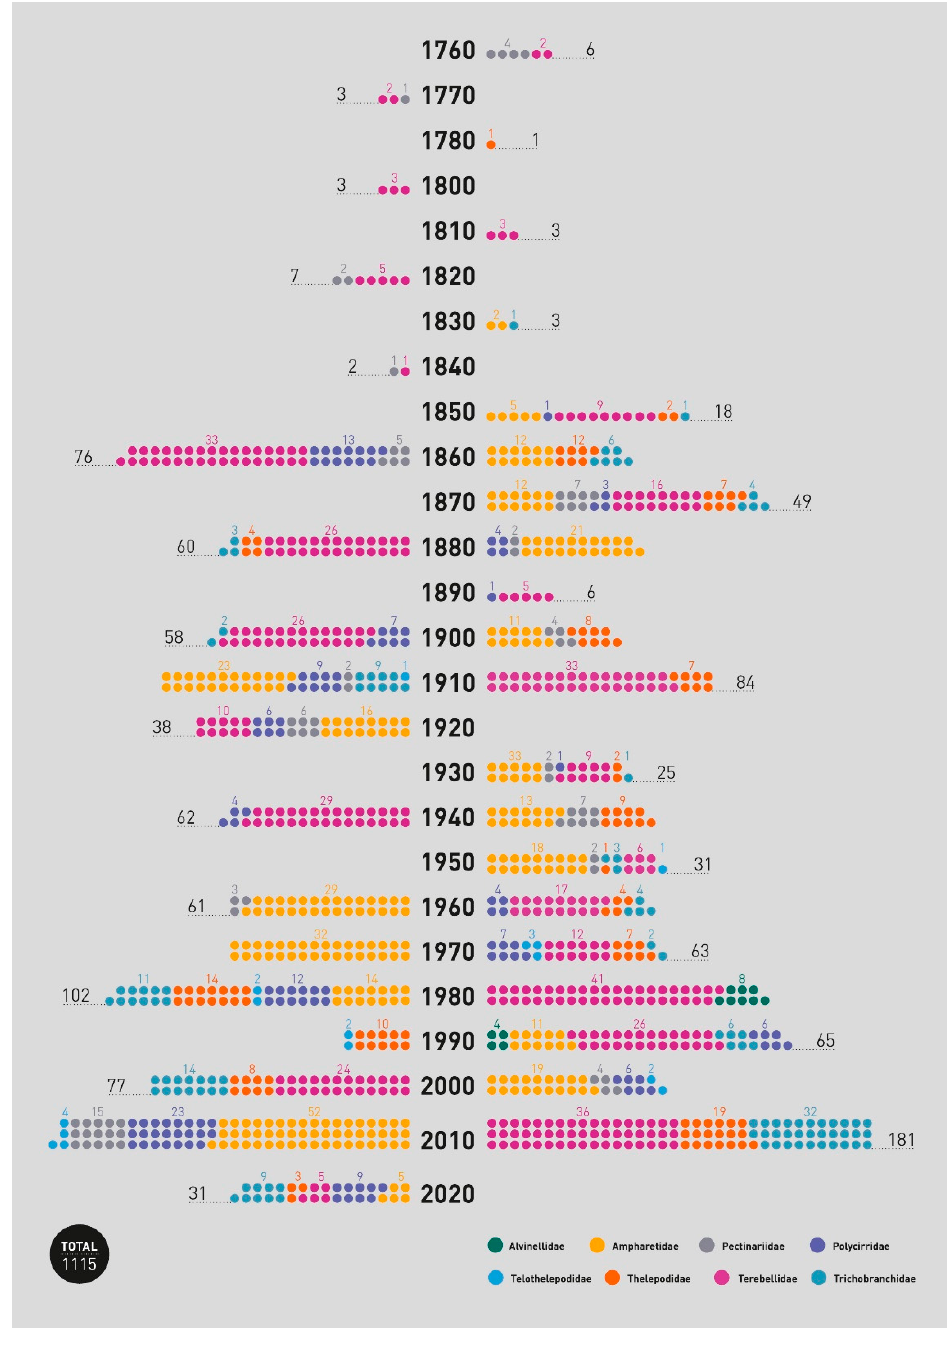
Figure 4. Number of Terebelliformia species described per period of ten years.